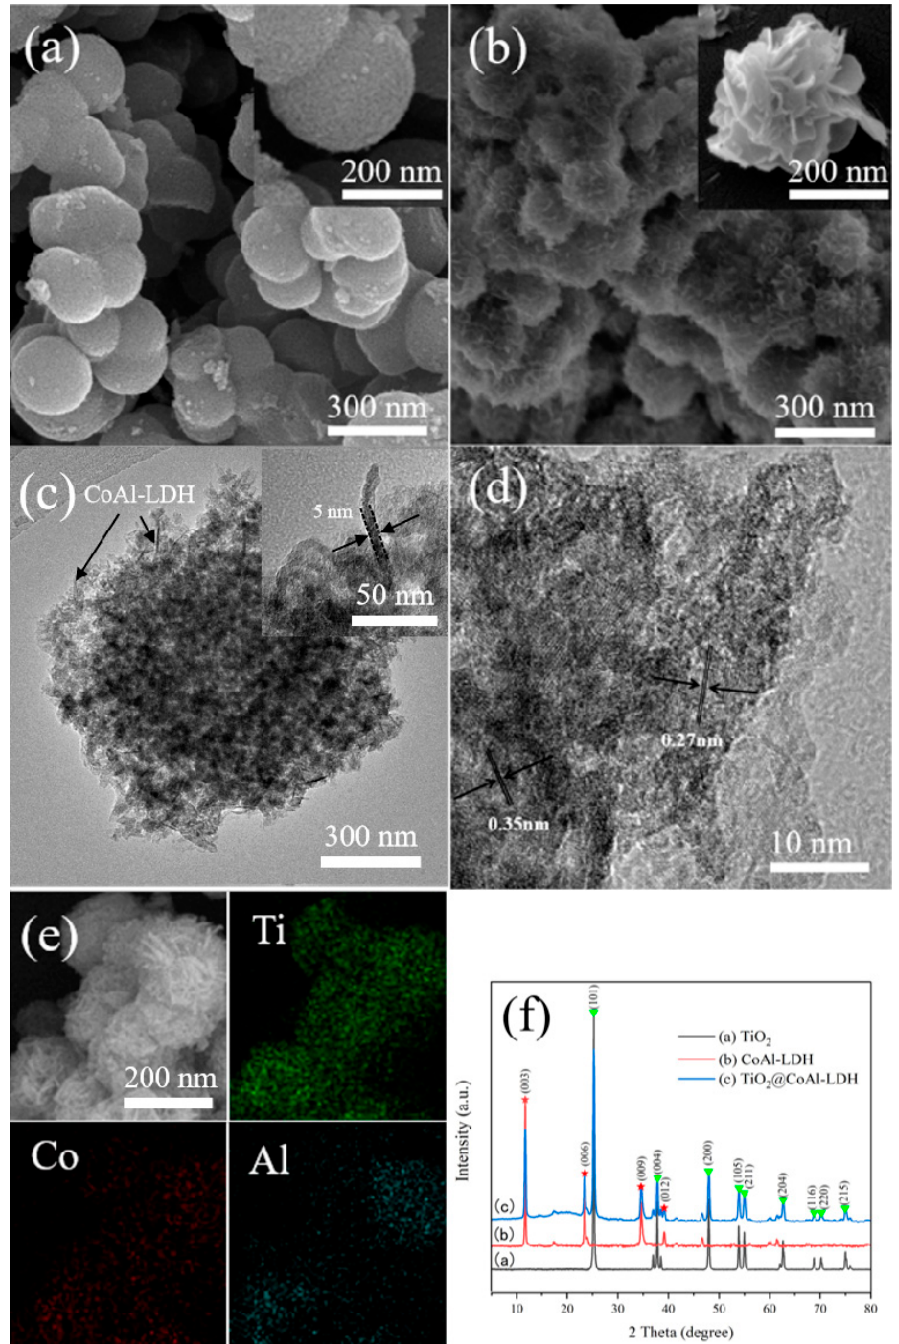
Figure 12. ( a ) SEM image of TiO 2 nanospheres; ( b ) SEM, ( c ) TEM, and ( d ) HRTEM images of TiO 2 @CoAl-LDH core@shell nanospheres; ( e ) SEM image and EDX mapping of TiO 2